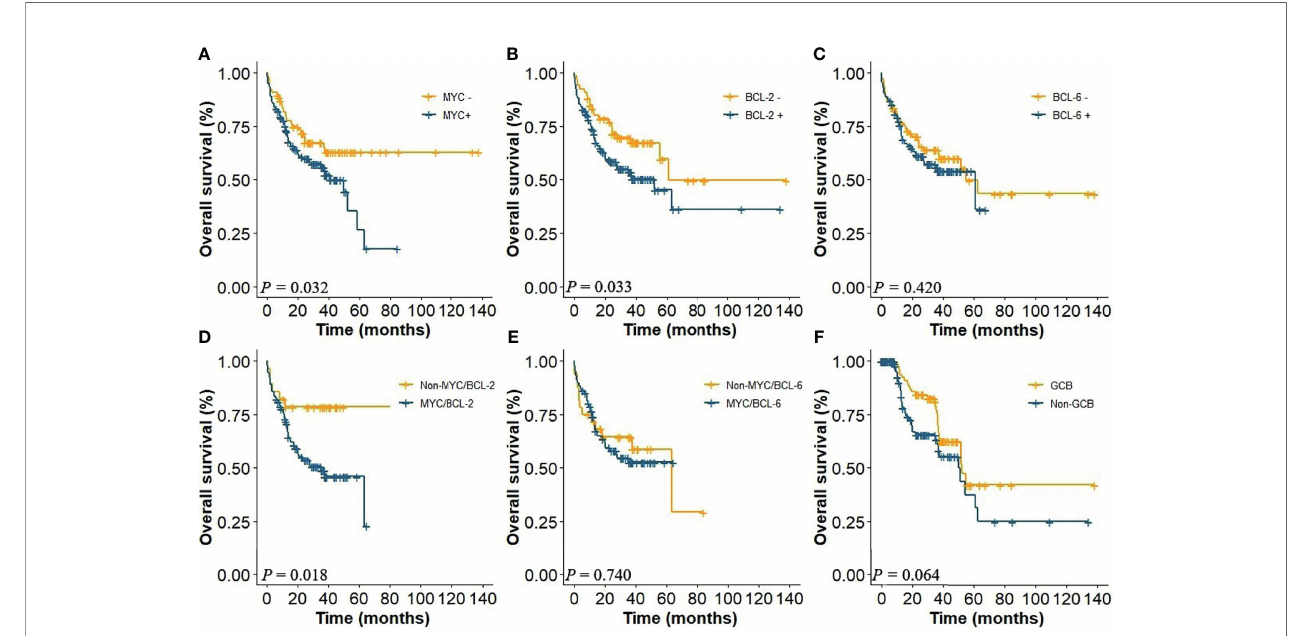
FIGURE 2 | (A) OS of CD5+ DLBCL patients with the presence or absence of MYC, (B) with the presence or absence of BCL-2, and (C) with the presence or absence of BCL-6. (D) Coexpression of MYC/BCL-2; (E) coexpression of MYC/BCL-6; (F) COO